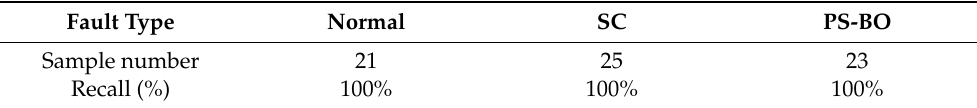
Table 5. Test result of the double-string experiment.